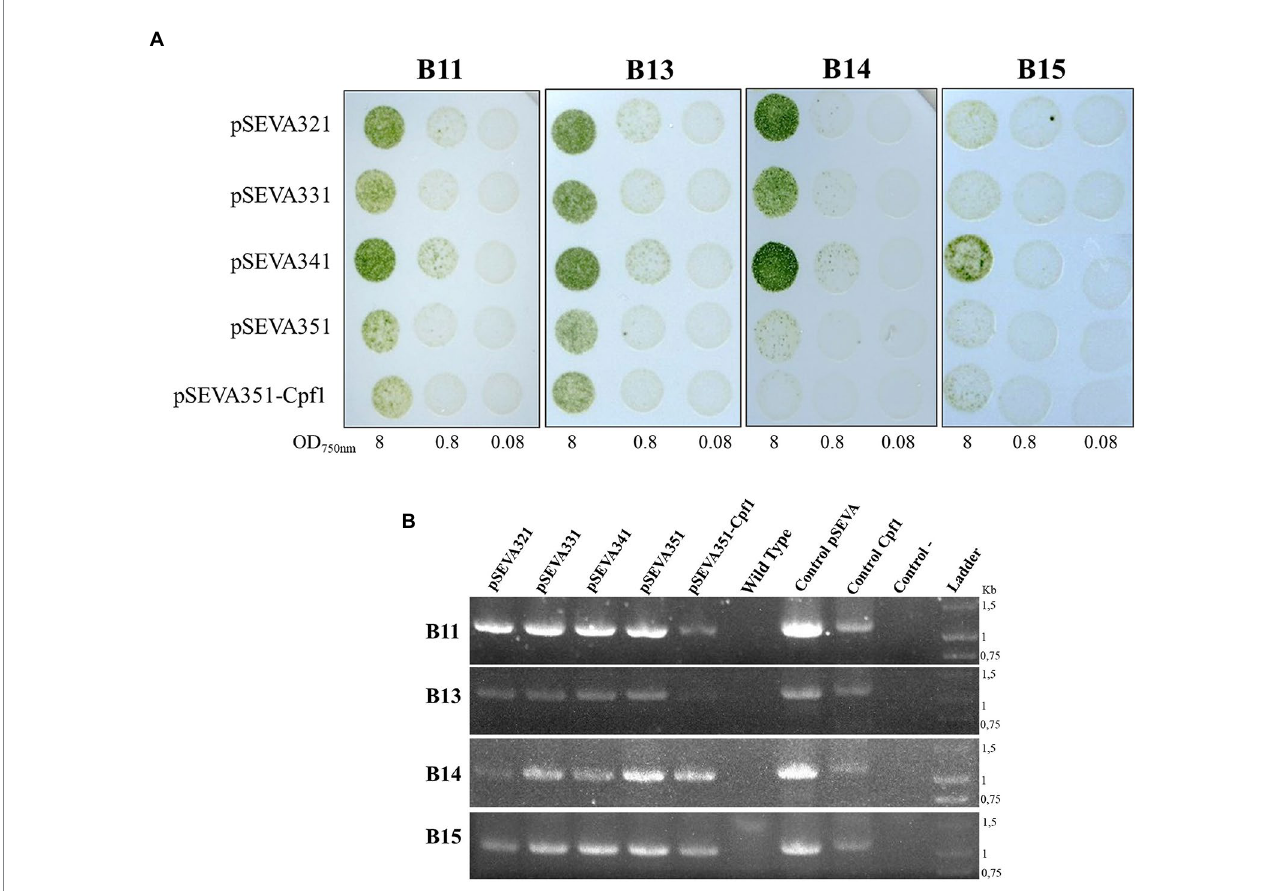
FIGURE 8 Triparental mating in Chroococcidiopsis isolates. (A) Result of the spot triparental mating for B11, B13, B14, and B15 isolates. Different OD 750nm were tested. (B) PCR confirmation of positive transformants of 7-day culture. Specific primers, amplifying chloramphenicol resistance gene in different plasmids, were used for verification (Supplementary Table S2): primers used for SEVA vectors (Oligo8/R24) yielded a 1 kb fragment; primers used for pSEVA with the CRISPR-Cas machinery (Oligo8/R24rv) yielded a 1.3 kb fragment. As positive controls, plasmid pSEVA351 (Control pSEVA) and pSEVA351-Cpf1 (Control Cpf1) were used; wild-type DNA of each isolate and water were used as negative